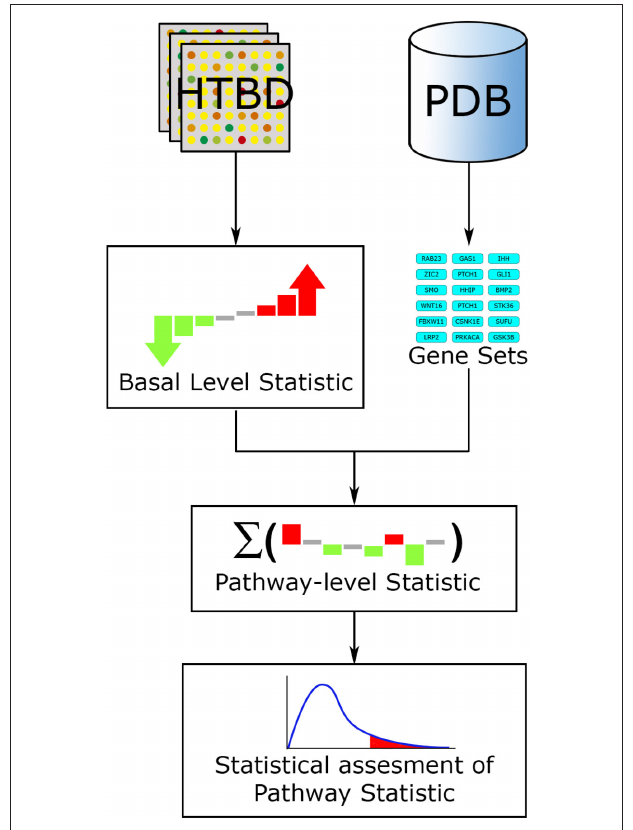
FIGURE 4 | FCS general workflow. The main input for FCS methods are the HTBD and the pathways extracted from PDBs, in gene set format. All HTBD is used to calculate the basal level statistics, giving each component a value dependent of its differential expression. After this, the basal-level statistics of the components of each pathway is aggregated in a pathway-level statistic. Finally statistical assessment of the pathway-level statistics is